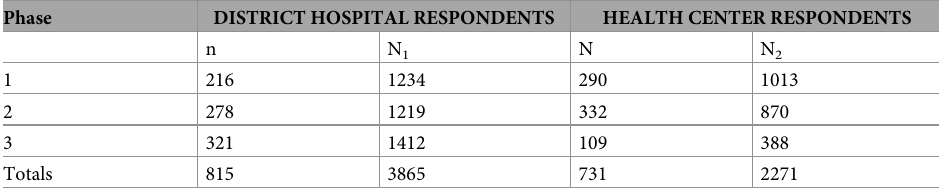
Table 1. Recruitment of questionnaire participants across